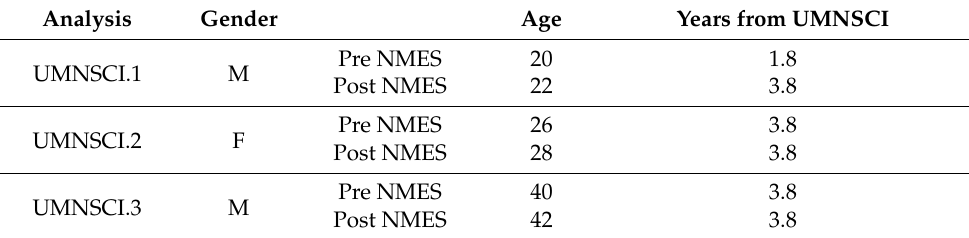
Table 1. Characteristics of UMNSCI